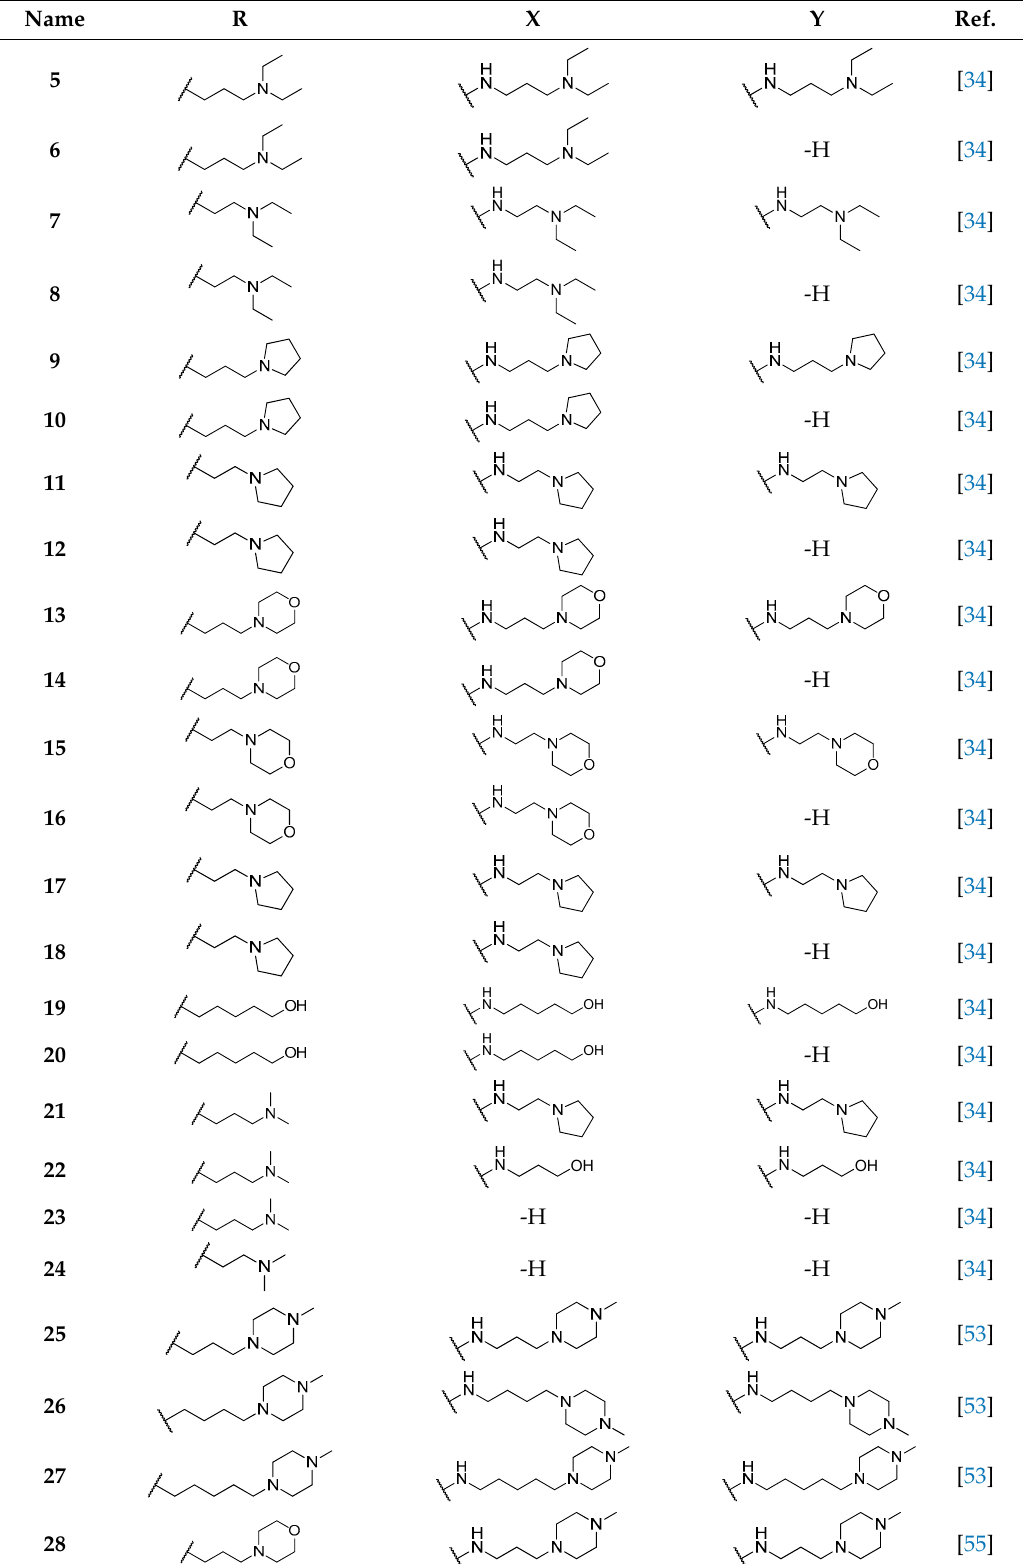
Table 1. Structures of NDIs used as reversible ligands to stabilize telomeric G4s.